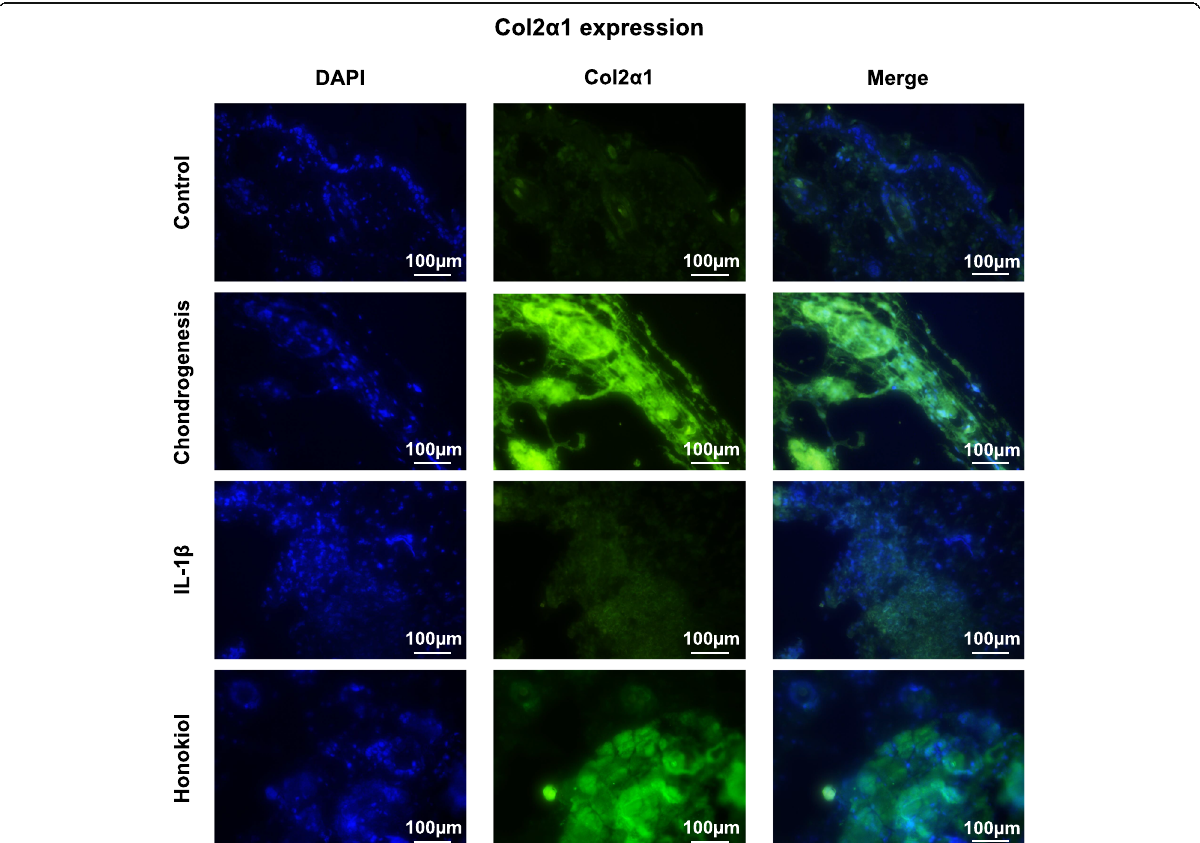
Fig. 6 Expression of Col2 α 1. Immunofluorescent staining results of Col2 α 1 were representative of the cells obtained in 6 donors. DAPI stain (blue) indicated the cells, col2 α 1 stain (green) indicated the positive expression of col2 α 1 ( n =